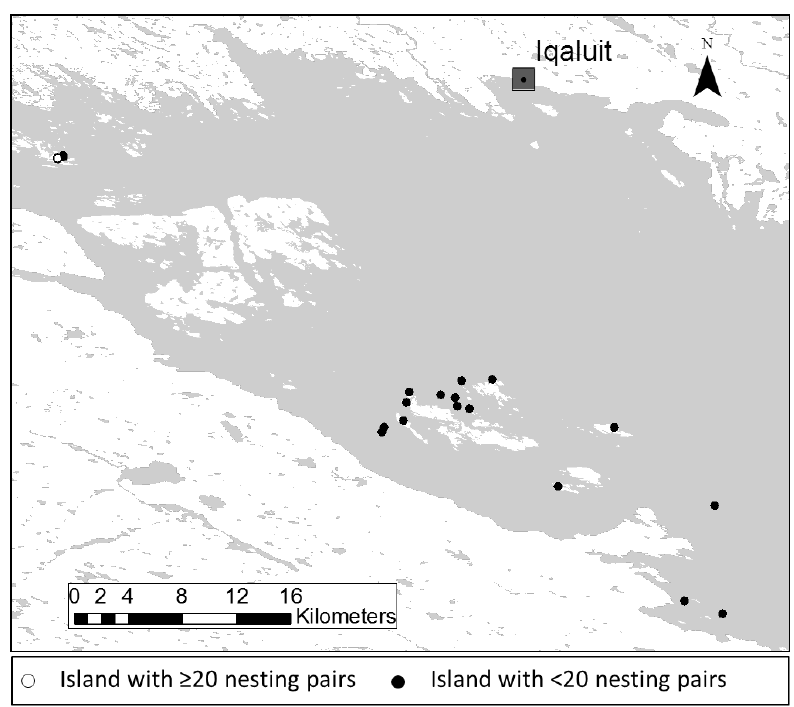
Figure A1.11. Survey zone 11: Northern Frobisher Bay, Frobisher Bay